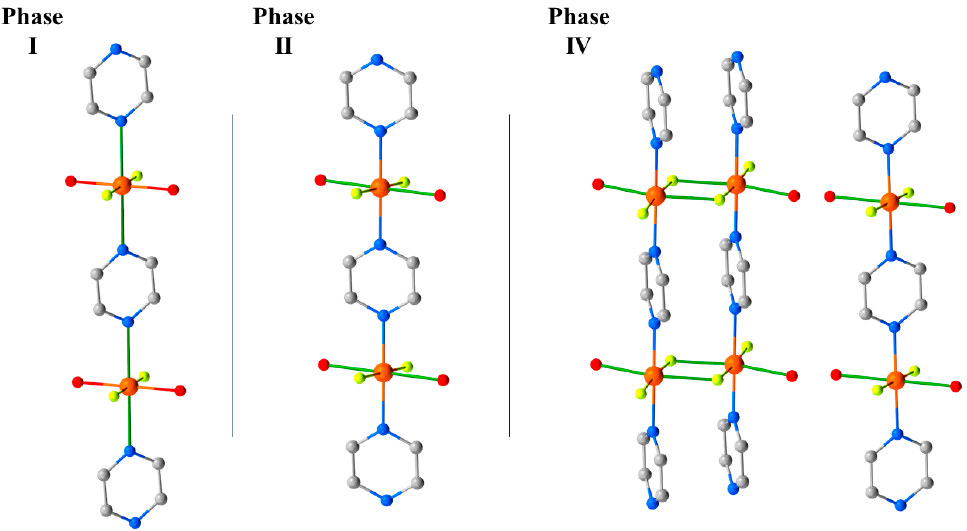
Figure 16. Phases I, II, and IV observed in the HP single-crystal XRD for complex 12 . The green bonds highlight the orientation of JT axis ( d z 2 ) of the Cu II ion along the a -axis of the cell. The magnetic d x 2 − y 2 orbital lies perpendicular to this, in the bc plane. Phase III observed in the pXRD measurements [59] was not seen in the single-crystal XRD measurements. Colour code is the same as in Figure 15. H atoms are omitted for clarity.